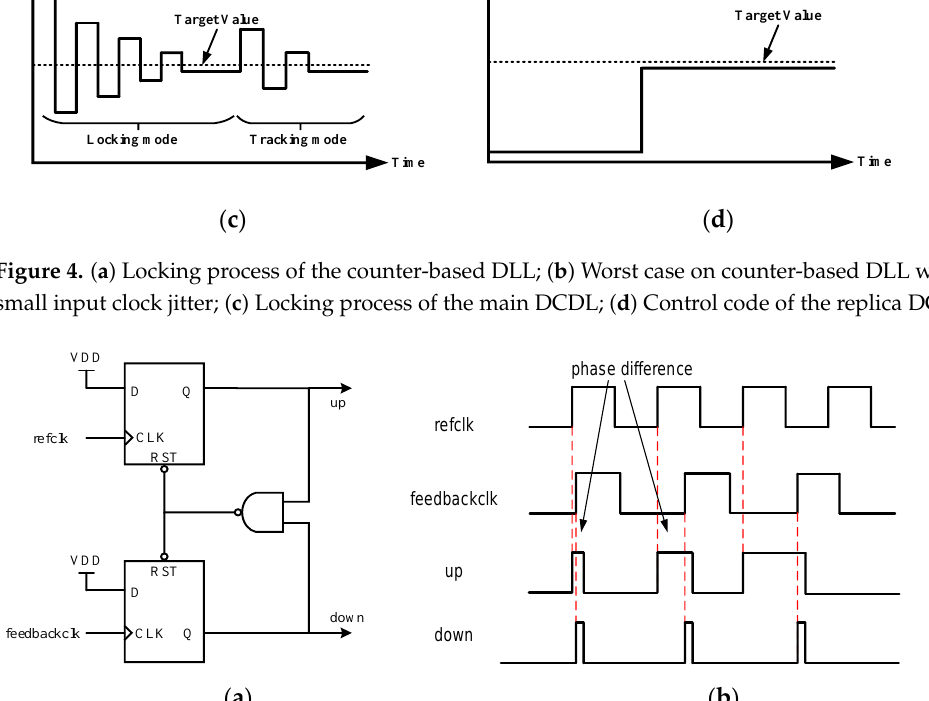
Figure 4. ( a ) Locking process of the counter-based DLL; ( b ) Worst case on counter-based DLL with a small input clock jitter; ( c ) Locking process of the main DCDL; ( d ) Control code of the replica DCDL.